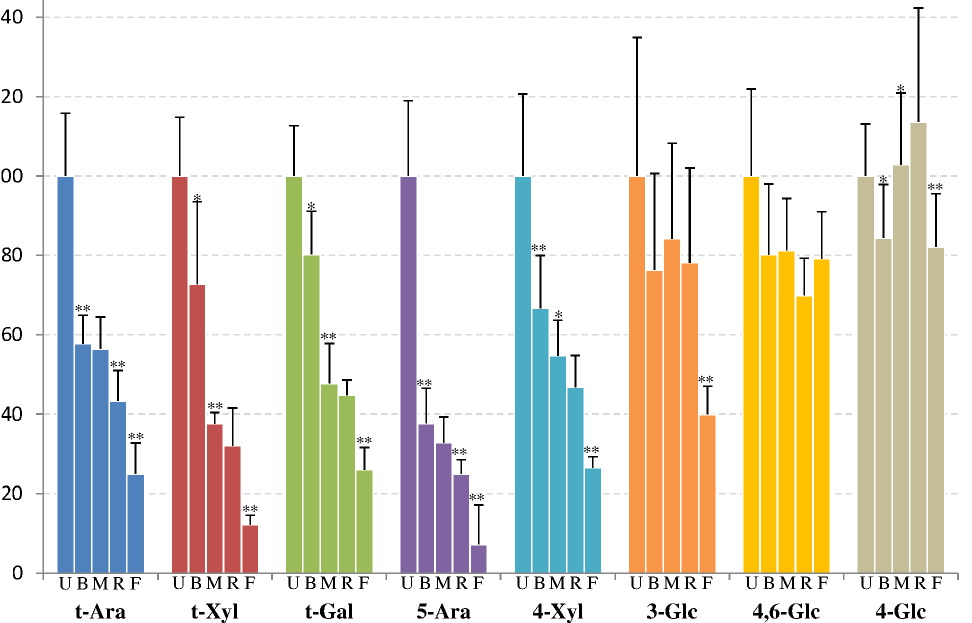
Fig. 5. Polysaccharide linkages of powdered textile processing samples: major linkages obtained after partial methylation and hydrolysis of samples. From left to right for each linkage: U 5 Untreated, B 5 Bleached/scoured, M 5 Mercerized, R 5 Ready to dye and F 5 Finished. Error bars represent standard deviation (n 5 at least 3). * and ** indicate significant difference between a sample and the preceding one at p , 0.05 and p , 0.01,